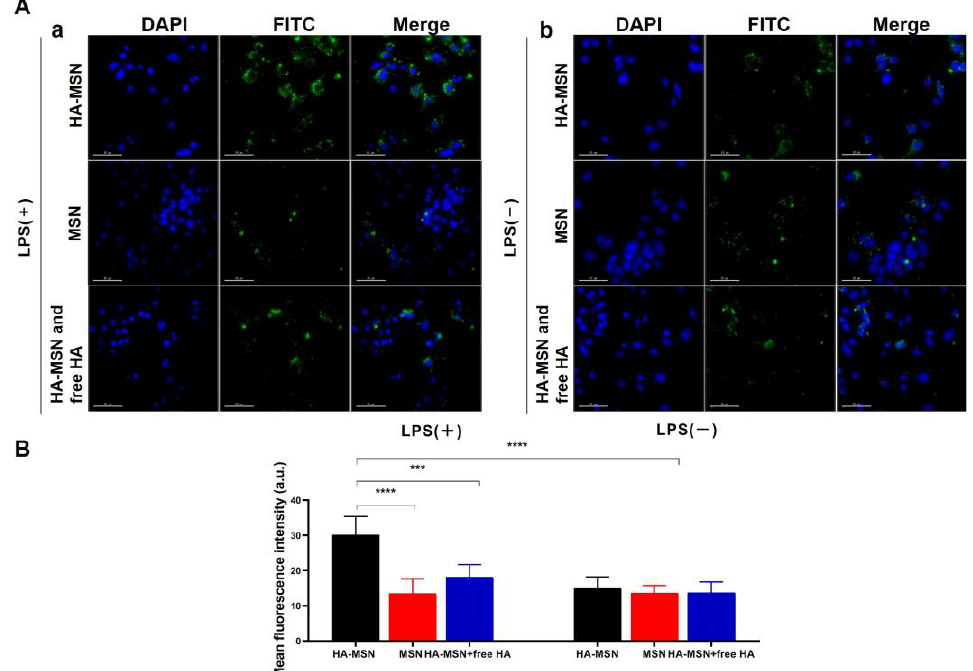
Figure 5. ( A ) Confocal laser microscope images of Raw264.7 cells treated with FITC-labeled HA- MSN, MSN, and free HA + FITC-HA-MSN for 2 h with ( a ) or without ( b ) LPS activation. ( B ) Mean fluorescence intensity of FITC-HA-MSN, FITC-MSN, and free HA + FITC-HA-MSN after cellular uptake ( n = 3). Variance among groups was determined by one-way ANOVA with Tukey post-hoc test (*** p < 0.001, **** p <